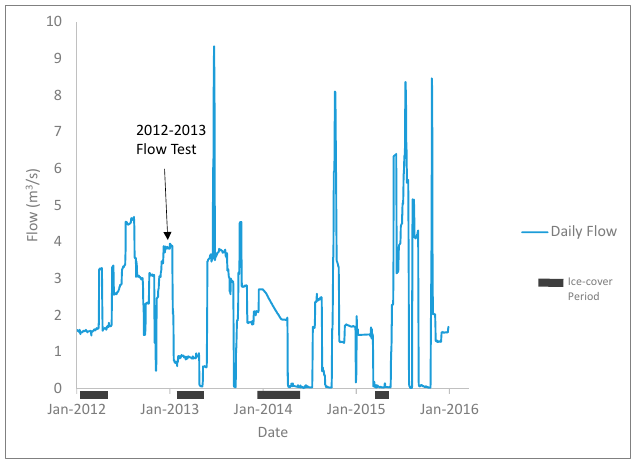
Figure 2. Upper Qu’Appelle River flow between 2012 and 2015 with indicated ice cover periods and 2012–2013 winter flow test.